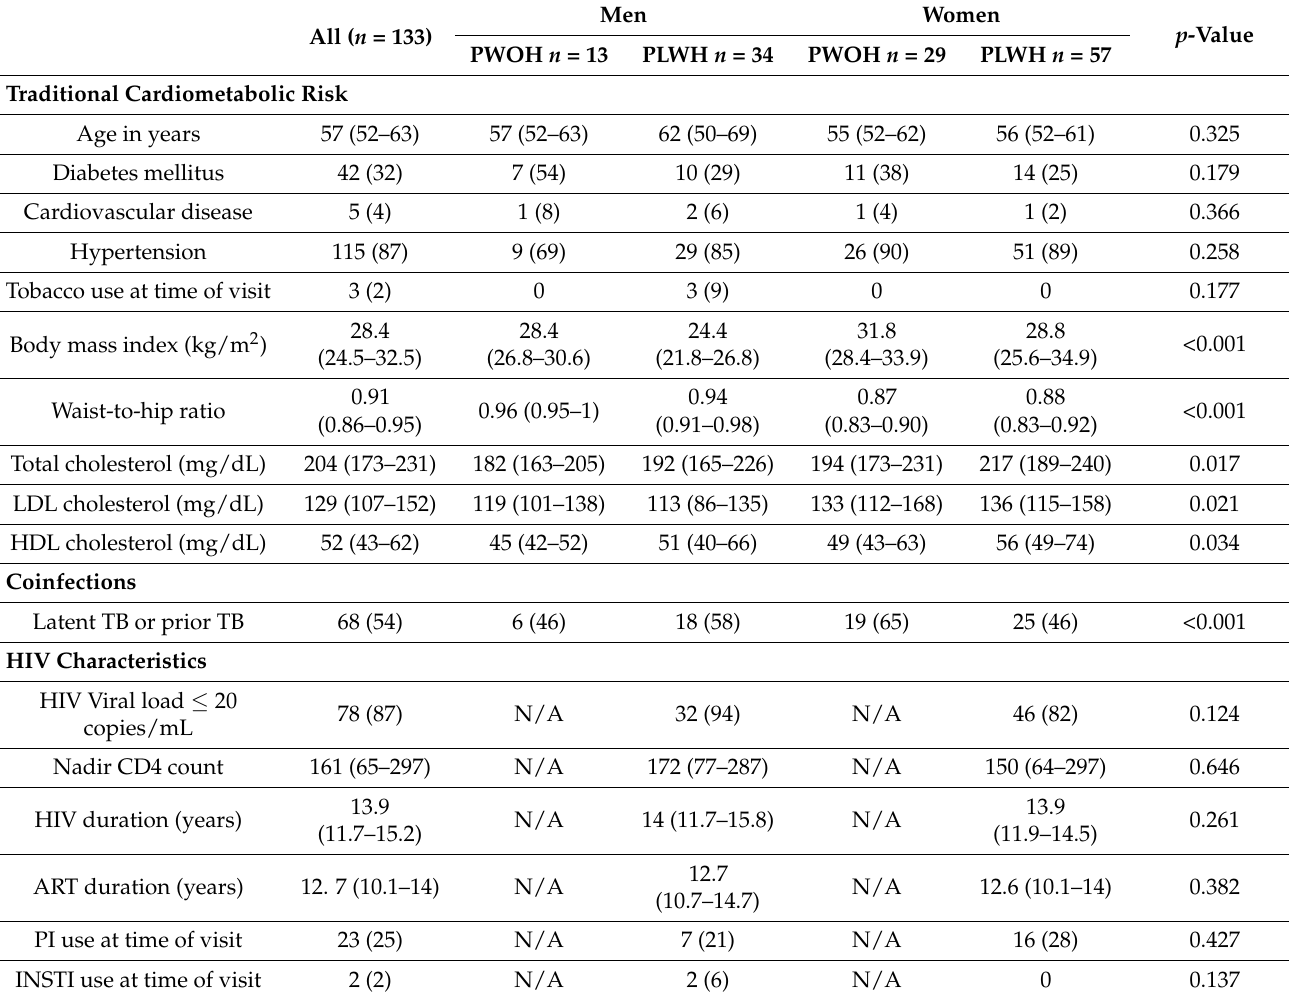
Table 1. Characteristics of the study population by sex and HIV